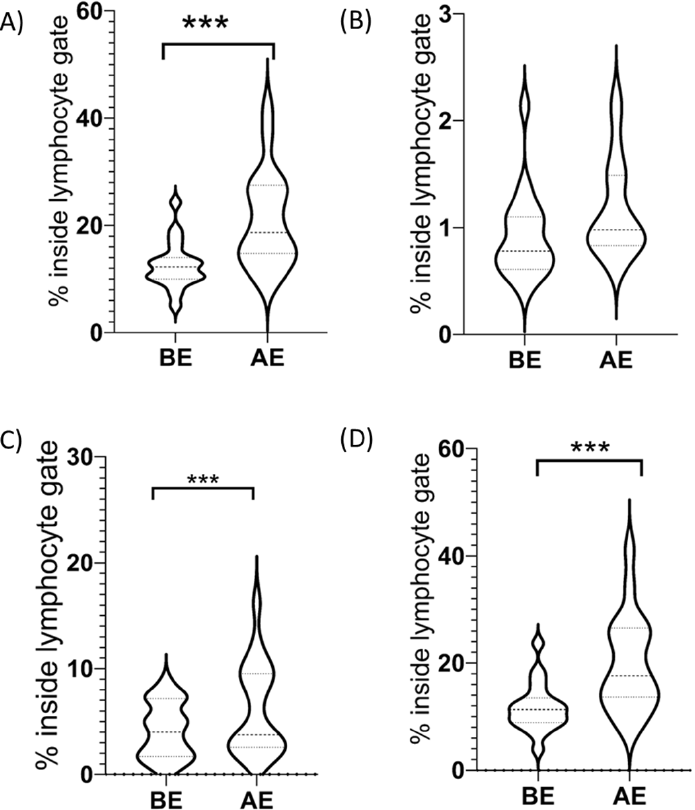
Figure 1. Frequencies of NK cell subsets. Violin plots show frequencies of NK cell subsets inside the lymphocyte gate before and after exercise: ( A ) CD3 − /CD56 + NK cells, ( B ) CD3 − /CD56 bright+ NK cells, ( C ) CD3 + /CD56 + NKT-like cells, ( D ) CD3 − /CD56 dim+ NK cells. *** p < 0.001 (Wilcoxon